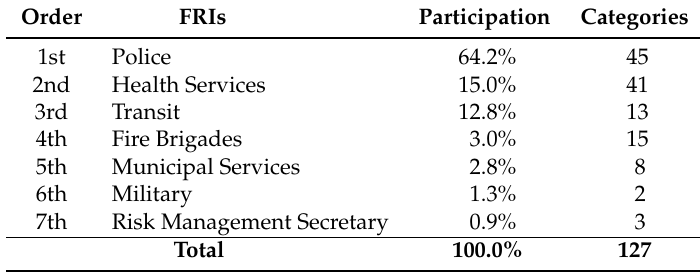
Table 4. Percentage of emergencies attended during 2014, and the number of categories per each FRI in Quito PSAP.